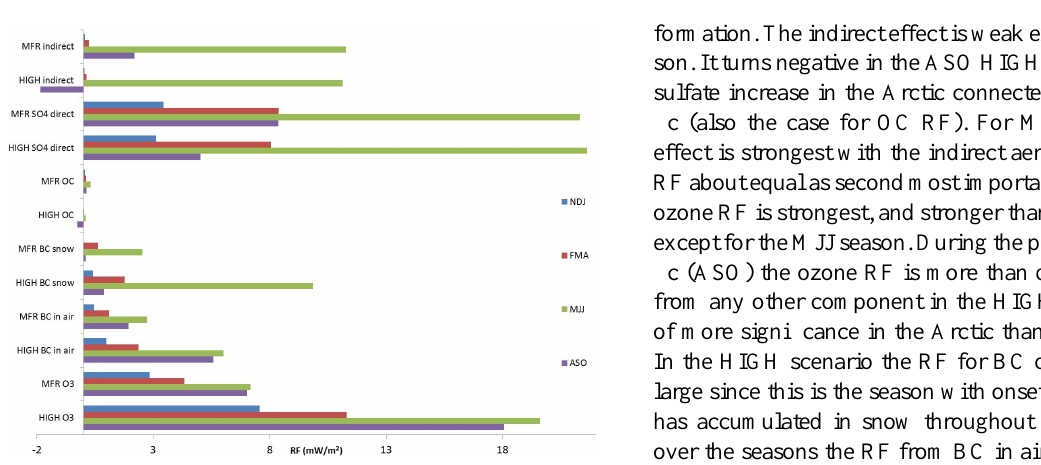
Fig. 11. RF 2004–2030 (mWm − 2 ) in the Arctic (60–90 ◦ N) for dif- ferent seasons and components for the scenarios HIGH and